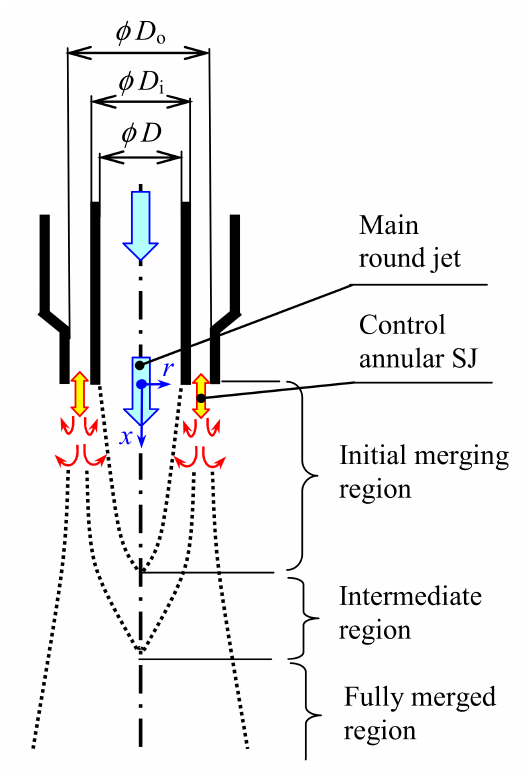
Figure 1. Schematic view on the studied coaxial jets. The investigated range of Reynolds numbers is Re = U m D / ν = 1082–5181. Due to the chosen Re range, the flow issuing from the pipe end covers laminar, transitional, and turbulent regimes with an intermittent